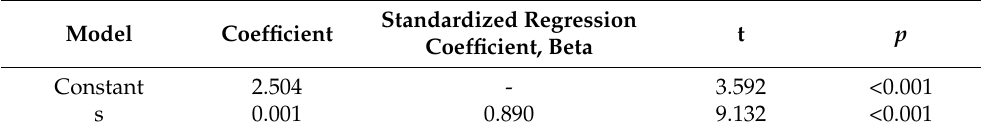
Table 21. Coefficients of the regression model for slurry pot test.